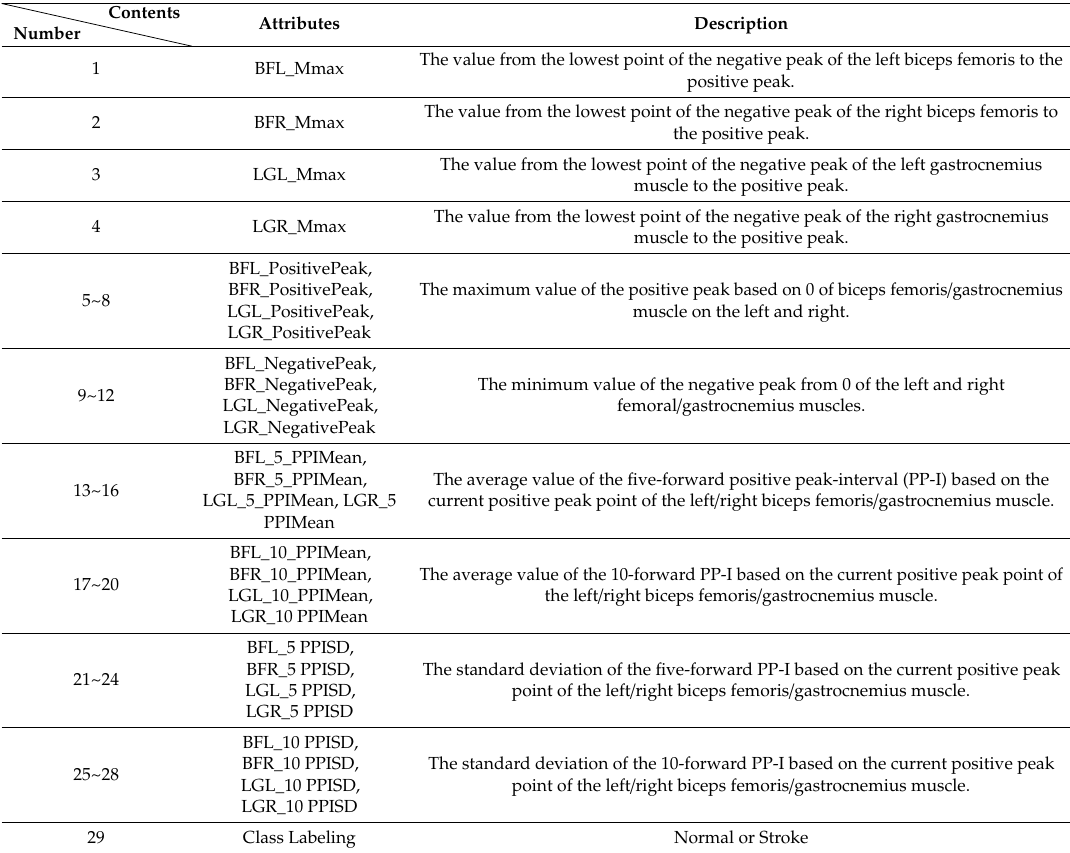
Table 1. Detailed Descriptions of Newly Defined and Extracted EMG Attributes.